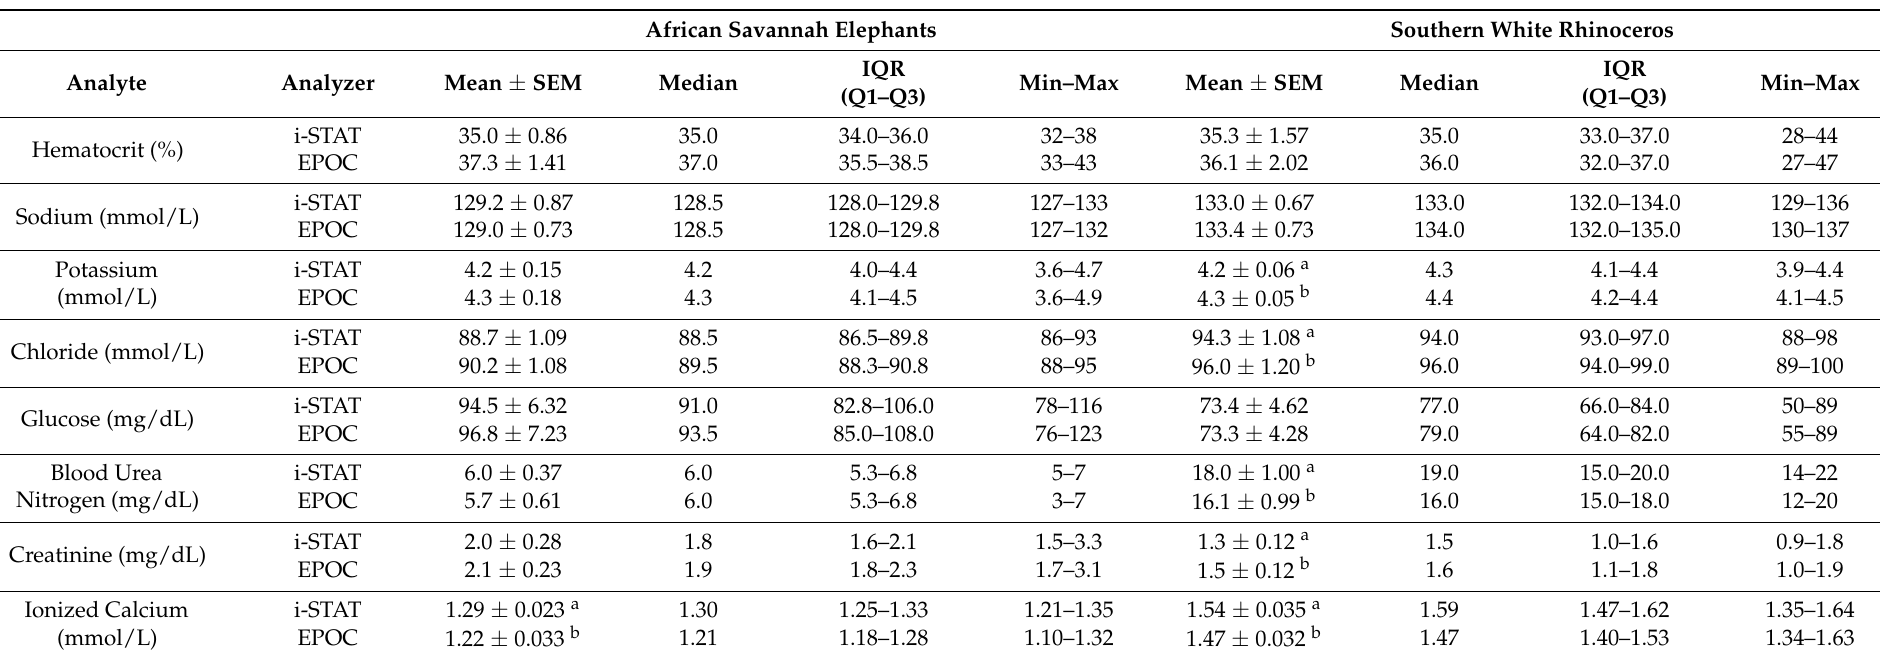
Table 3. Descriptive statistics of hematocrit and biochemical values in African savanna elephants ( Loxodonta africana ; n = 6) and southern white rhinoceros ( Ceratotherium simum simum ; n = 9) measured by the i-STAT Alinity v and EPOC analyzers. African Savannah